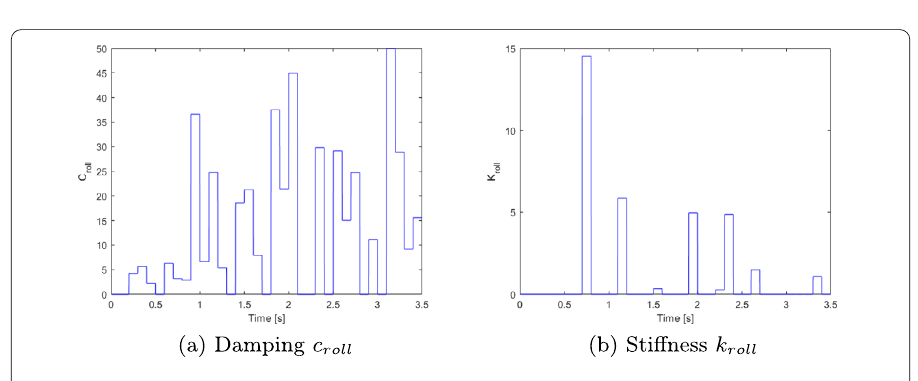
Figure 10 Damping and stiffness for the roll